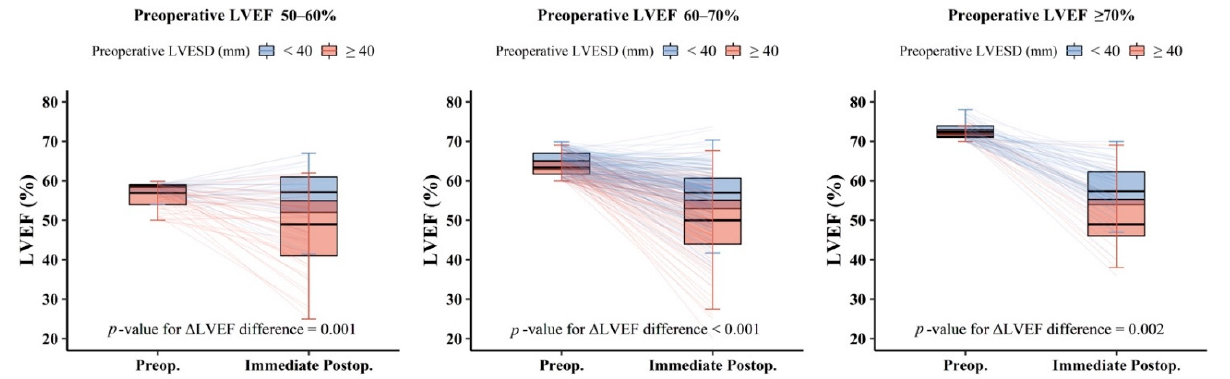
Figure 3. Immediate postoperative LVEF after mitral valve repair for chronic primary mitral regurgitation according to preoperative LVESD. LVEF: left ventricular ejection fraction; LVESD: left ventricular end-systolic diameter.